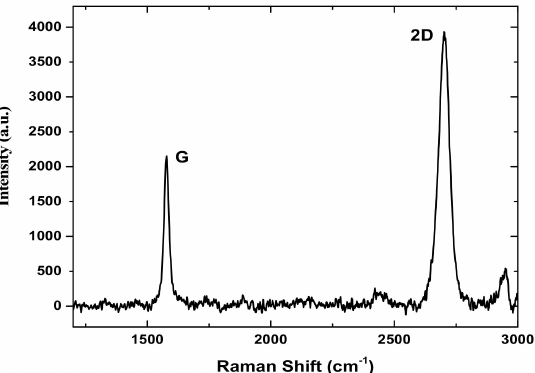
Figure A3. Raman spectrum of graphene deposited on 487 nm PMMA/SPF with 514 nm wavelength laser excitation. G and 2D bands are located at 1578.2 and 2701.9 cm − 1 , respectively. I 2D /I G = ~1.83.